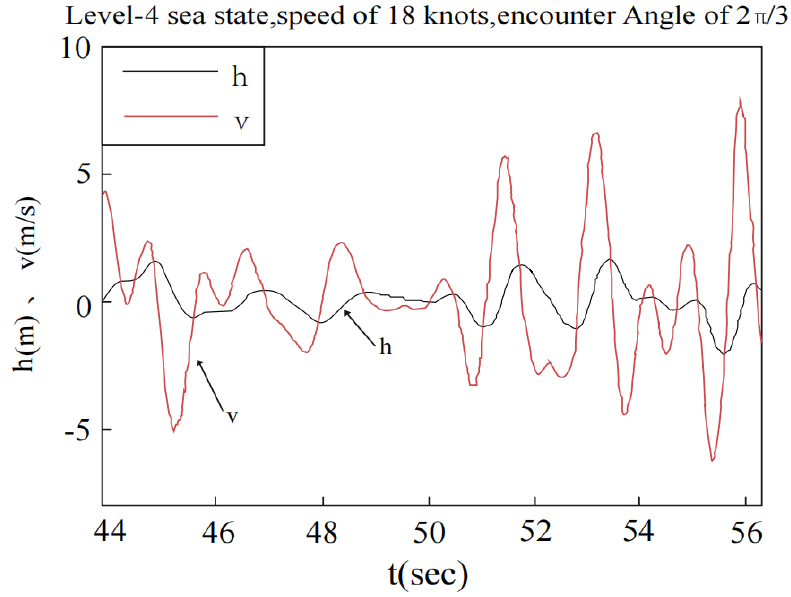
Figure 18. The curves of landing point height and its change rate under level-4 sea state, navigational speed V = 18 Kn , encounter angle β = 2 π